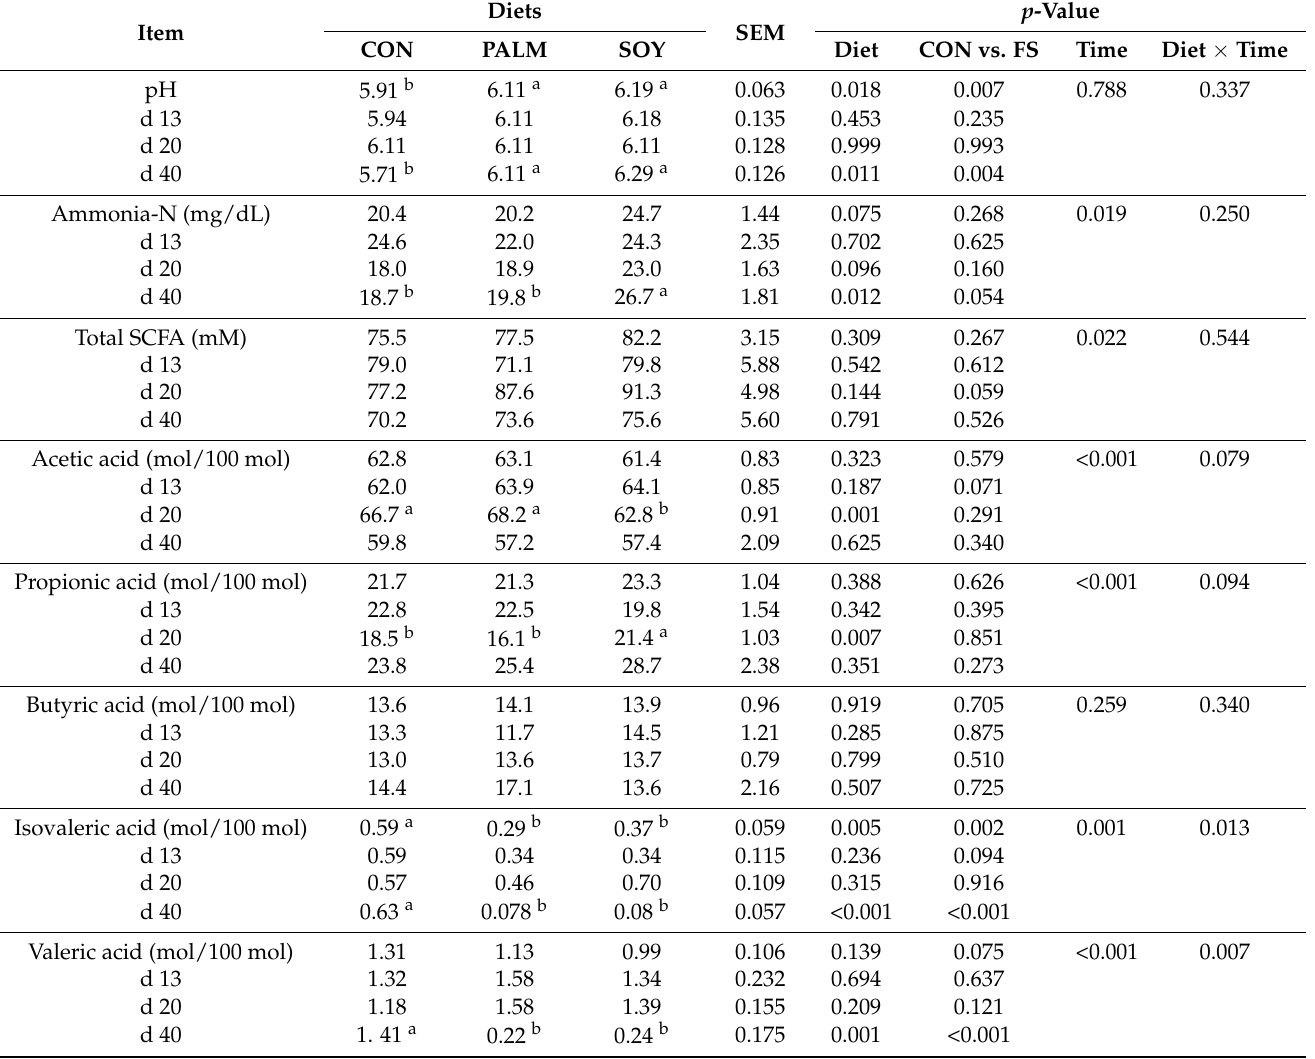
Table 4. Ruminal fermentation characteristics of lambs fed diets with fat supplements (FS; 50 g/kg) of prilled palm oil (PALM), soybean oil (SOY), or without fat supplementation (CON).